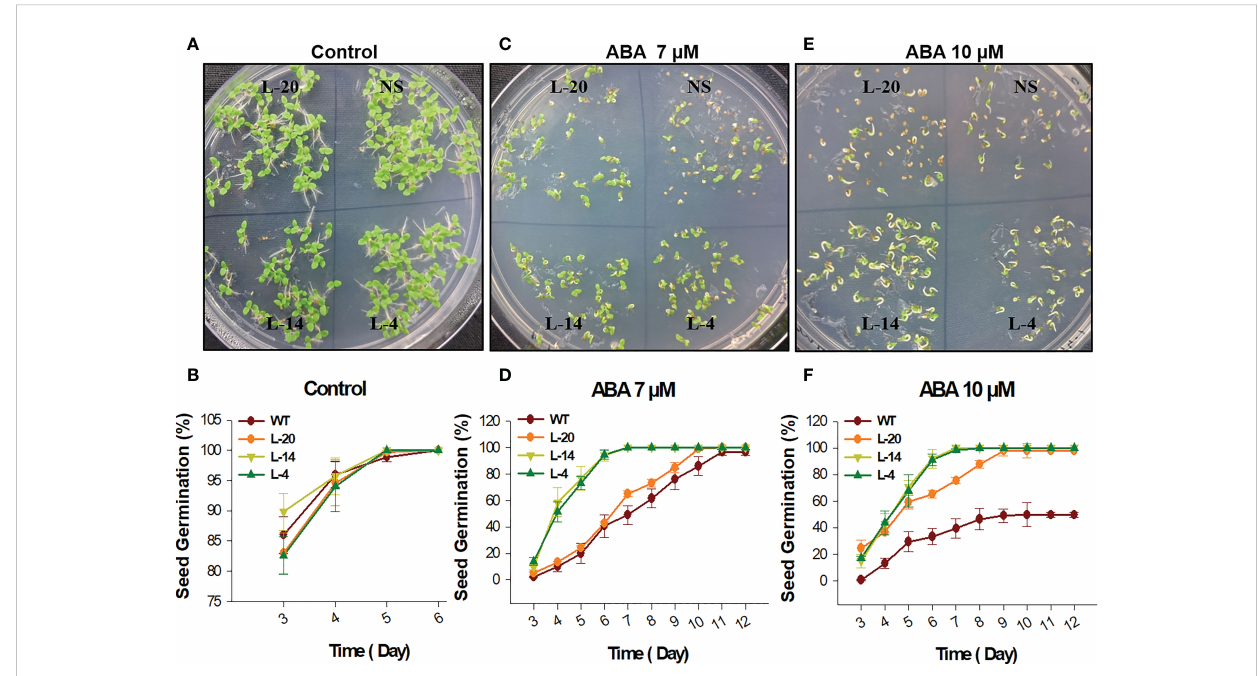
FIGURE 3 Seed germination analysis of VaDJI transgenic lines for ABA insensitivity; (A, C, E) Represents phenotypic difference during control, 7 µM ABA and 10 µM ABA treatments, (B, D, F) germination percentage of NS and VaDJI transgenic lines under control, 7 µM ABA and 10 µM ABA stresses. Experiments were repeated with three technical and three biological repeats. Error bar depicts mean ±